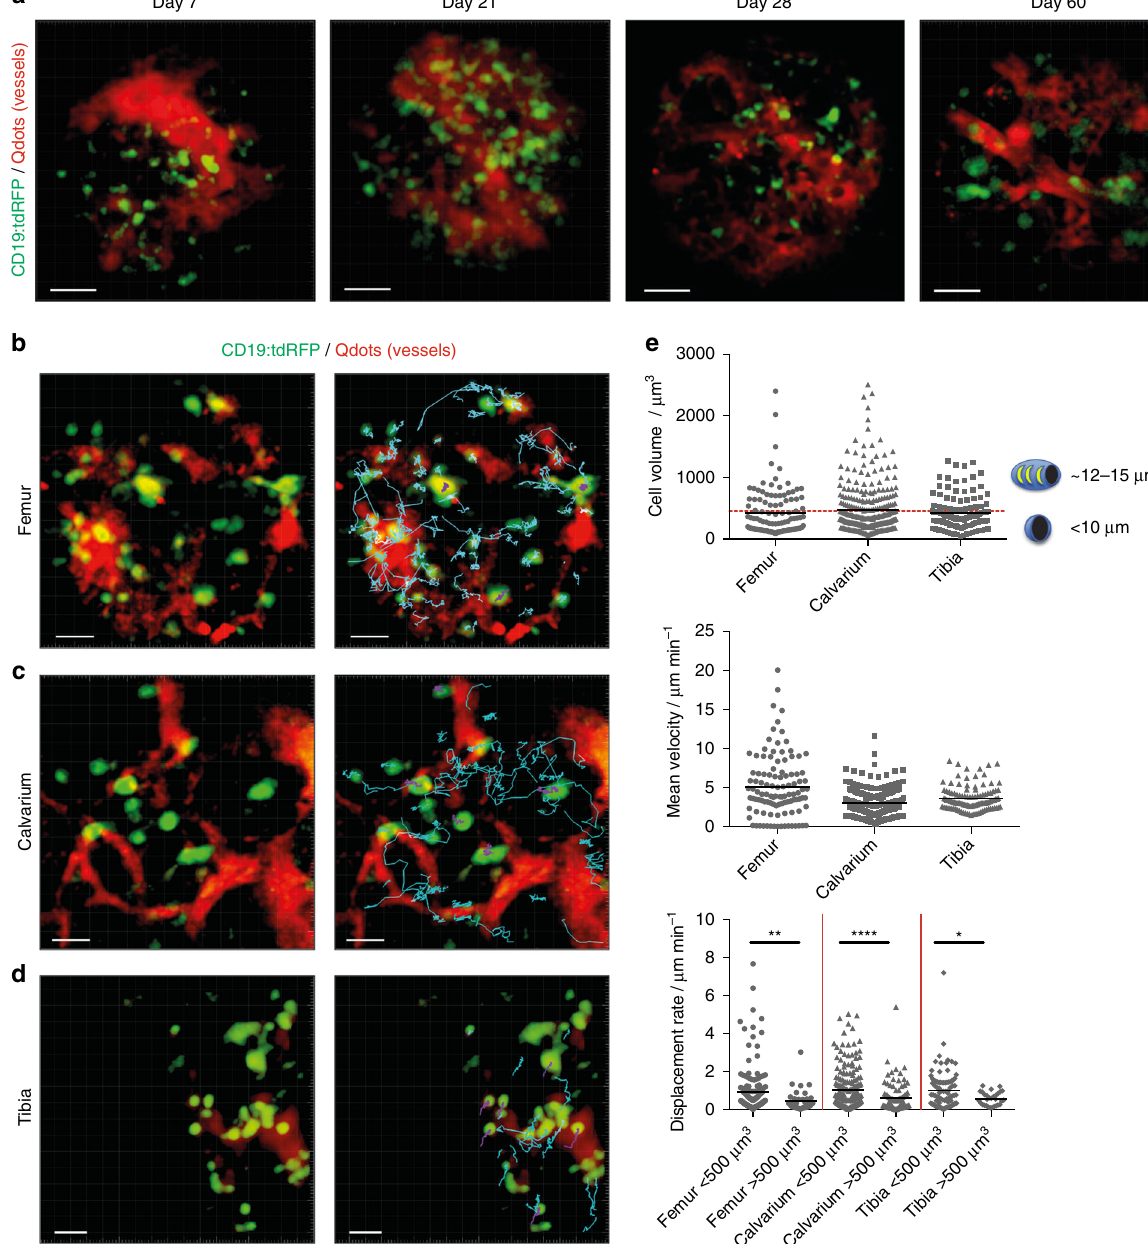
Fig. 4 Immune cell dynamics in different bone types show comparable motility patterns. a 3D fl uorescence images acquired by LIMB in the femoral marrow of a CD19:tdRFP mouse at day 7, day 14, day 28, and day 60 after surgery. Mature B lymphocytes express tdRFP and are displayed in green, whereas the vasculature was labeled with Qdots and is displayed in red. Scale bar = 50 µ m. All images are snapshots of 45 min movies, with images acquired every 30 s. The movies are provided as Supplementary Material. b Time-lapse 3D fl uorescence image acquired by LIMB in the bone marrow of a CD19:tdRFP mouse at day 90 post-surgery. The tracks of the B lymphocytes smaller than 500 µ m 3 (de fi ned as B cells with a maximum diameter of 10 µ m) are shown in cyan, whereas those with a volume larger than 500 µ m 3 (de fi ned as plasma cells) are shown in violet. Scale bar = 30 µ m. c Similar to b , time lapse 3D image of the bone marrow of a CD19:tdRFP mouse with corresponding tracks of B and plasma cells in the calvarium and d the tibia. Scale bar = 30 µ m. Representative movies with cell motility tracks for LIMB, calvarial, and tibial imaging are provided as Supplementary Material. e Quanti fi cation of cell volumes, mean velocities, and displacement rates of B lymphocytes from movies acquired by LIMB ( n = 4 mice), within the calvarial bone ( n = 3 mice), and the tibia ( n = 2 mice). Similar cell subset frequencies and mean velocities of B lymphocytes were measured by LIMB in the femoral bone marrow, by calvarial imaging as well as by tibial imaging. We statistically analyzed the data in e using t -test (* p < 0.05; ** p < 0.01; *** p <